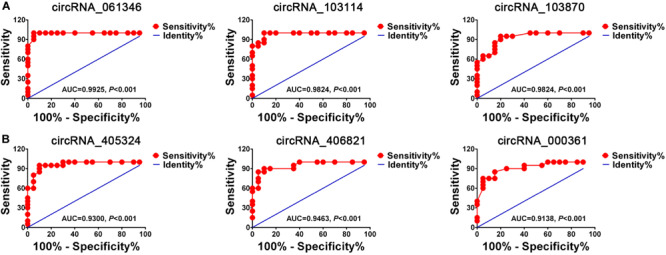
The diagnostic value of six candidate circRNAs in GISTs. (A) ROC curve for three up-regulated circRNAs. (B) ROC curve for three down- regulated circRNAs.